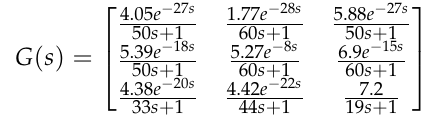
Figure 18. The control signal 𝑢 2 for all three methods by applying uncertainty.